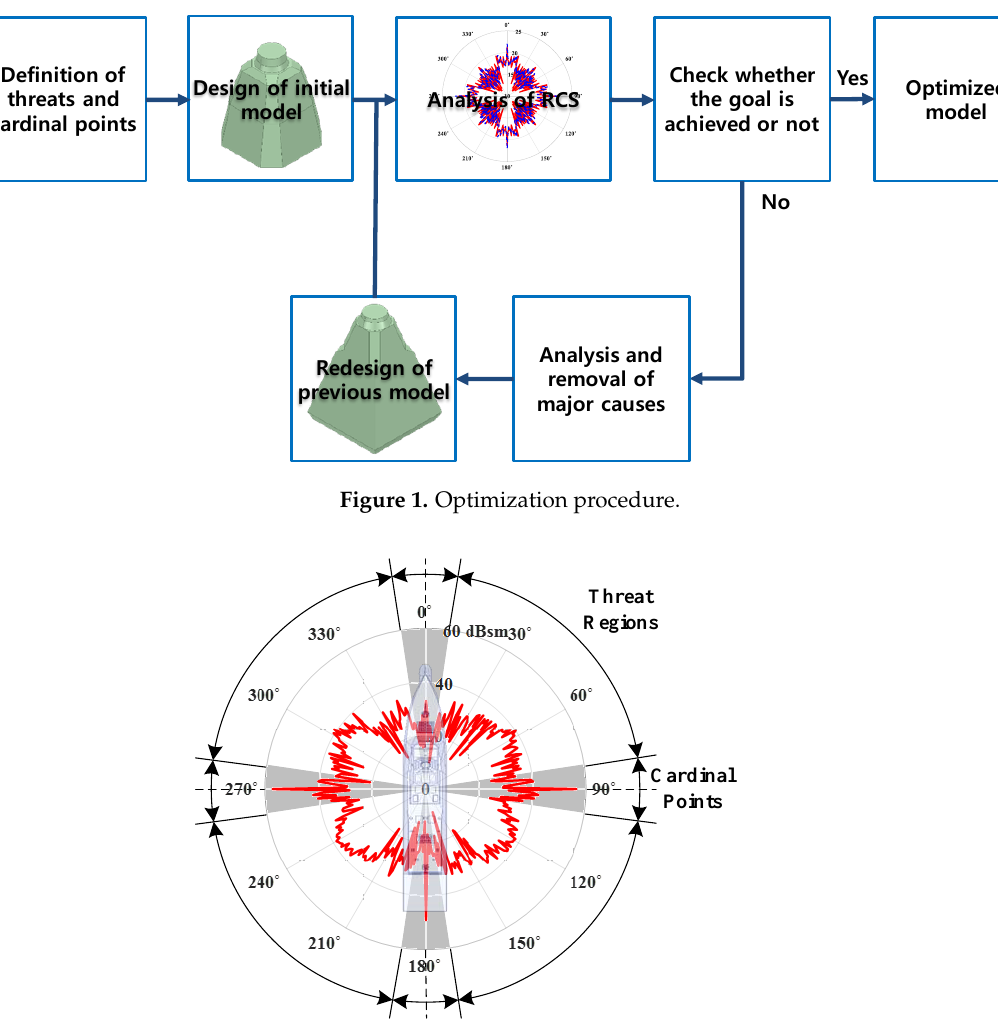
Figure 2. Cardinal points of the naval vessel.